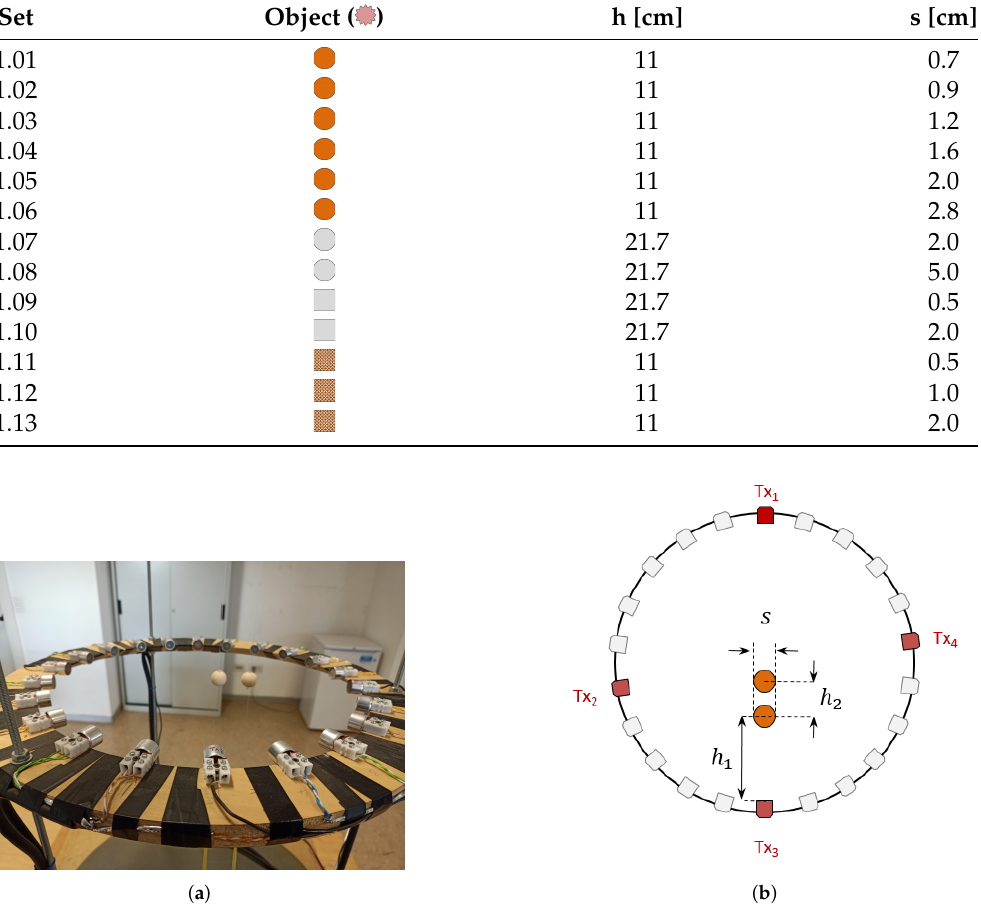
Figure 5. Scenario 1: single object of different shape, size and material. ( a ) Picture of an acquisition and ( b ) its sketch in a two-dimensional plane. Table 2. Scenario 1: single object of different shape, size and material (Figure 5). The quantity s refers to the diameter for spherical objects and to the side for cubes.